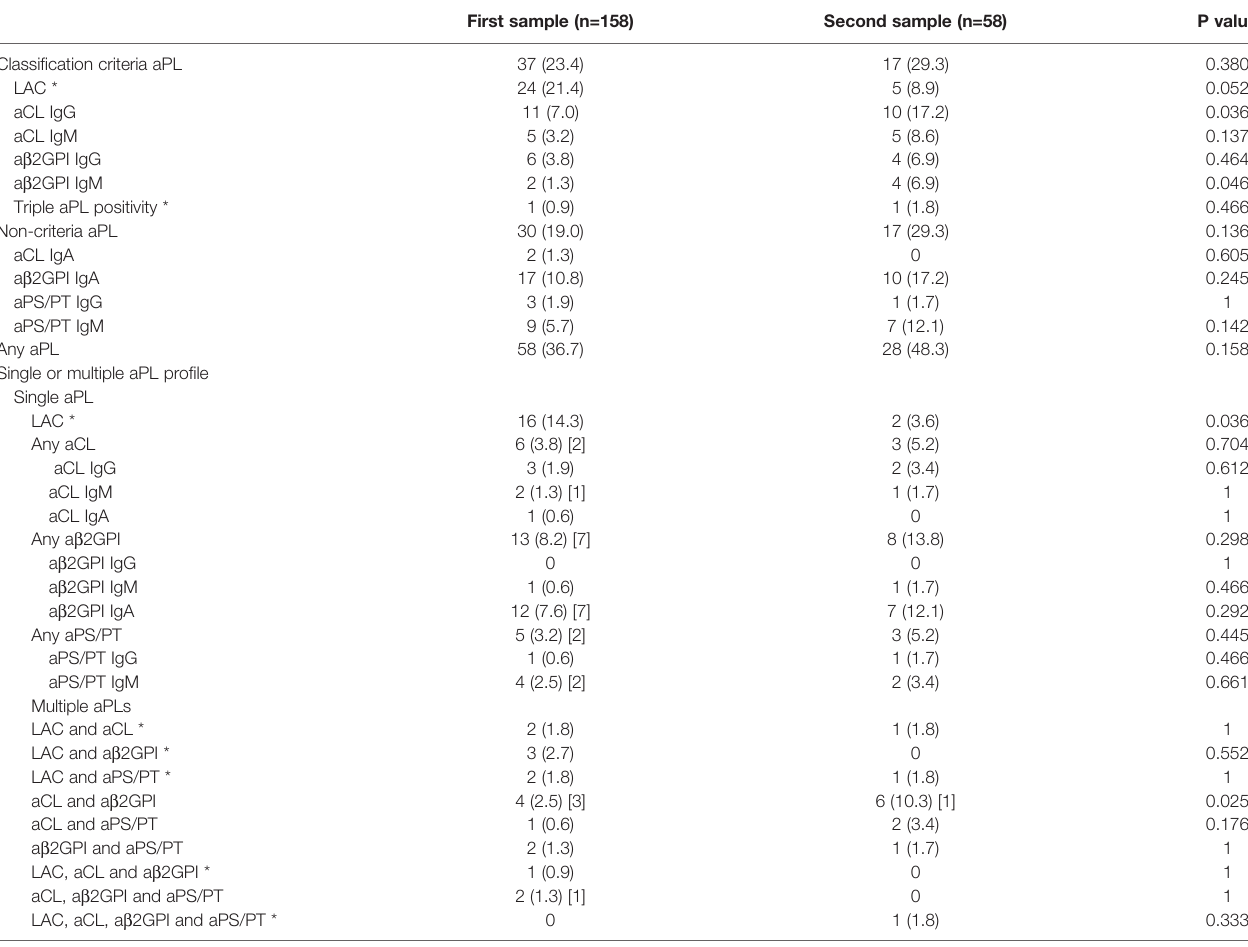
TABLE 2 | Prevalence and variability of antiphospholipid antibodies in patients with